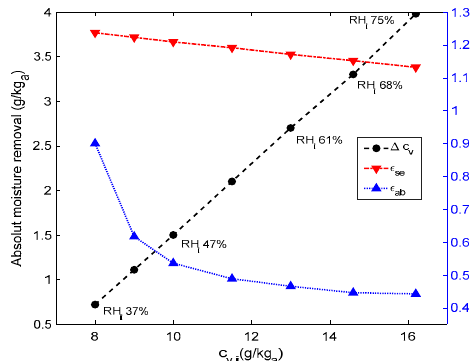
Figure 6. Effects of the inlet humidity on the absolute moisture removal, absorption, and sensible effectiveness parameters.